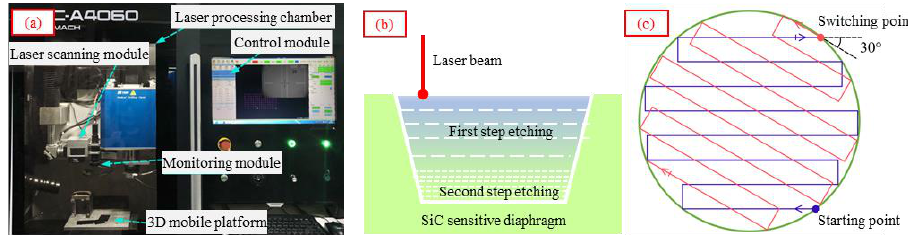
Figure 6. Key manufacturing process steps and test results of the SiC pressure sensor.